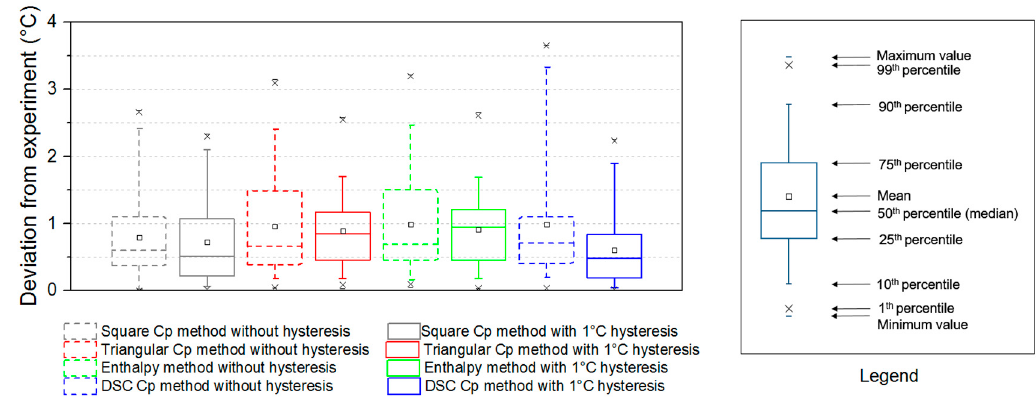
Figure 4. The deviation between the models and the experimental data.